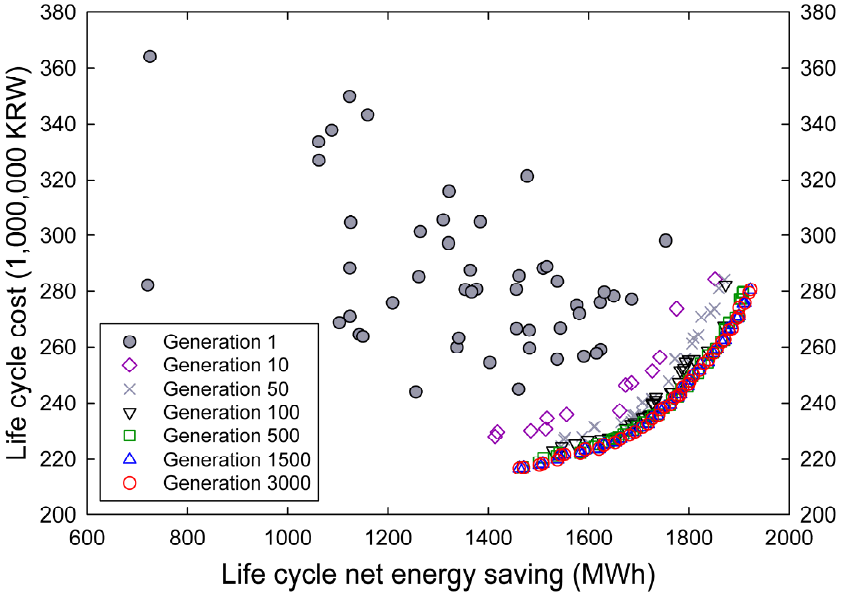
Figure 5. Evolution of Pareto frontier through many generations.